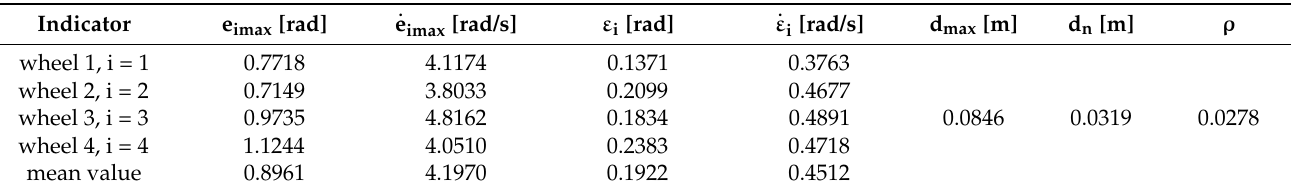
Table 4. Quality indicators for neural control